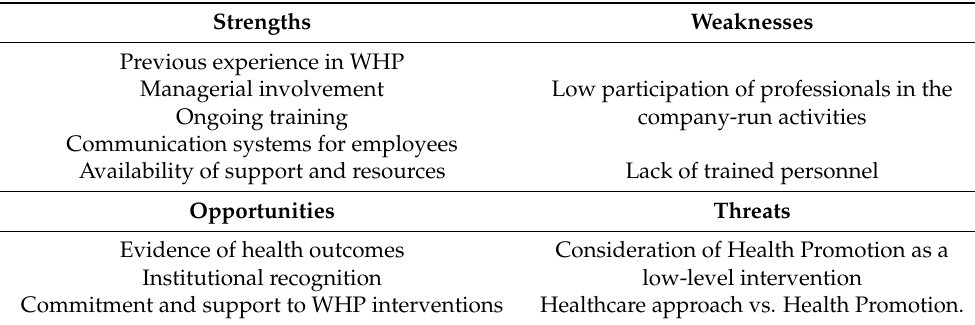
Table 1. Results of SWOT matrix by the Local Implementation Working Group identifying key priority areas for strategic action.